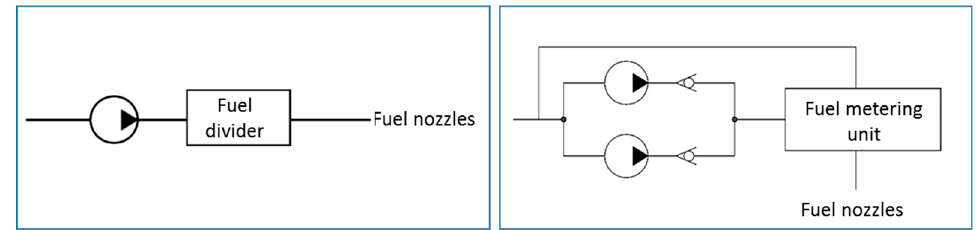
Figure 13. Fuel metering line diagram.